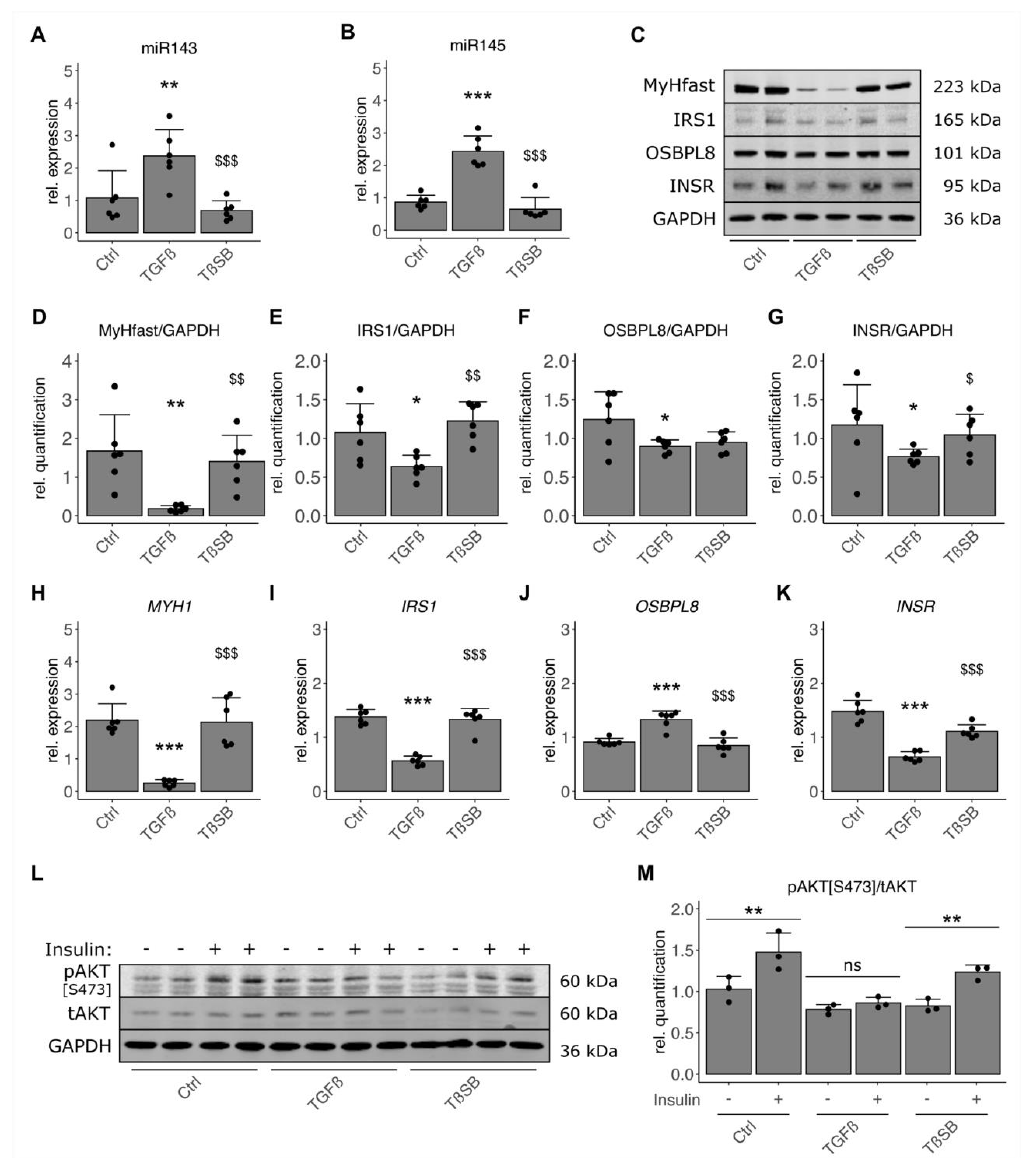
Figure 5. TGF- β 1 negatively impacts potential miR-143/145 cluster targets and insulin signaling in human skeletal muscle cells. Primary human myoblasts ( n = 6) were differentiated towards myotubes for 5 days in the absence of FBS and subsequently treated with 1 ng/mL of TGF- β 1 (TGF β ), TGF- β 1 plus inhibitor (10 µ M of SB431542) (T β SB), or vehicle control (Ctrl) for the last 48 h. Expression of mature miRNA ( A ) miR-143-3p, ( B ) miR-145-5p was detected by qPCR. ( C ) Protein levels of MYH1/2 (MyHfast), IRS1, OSBPL8, and INSR were detected by Western Blot and quantified ( D – G ) by normalizing to internal loading control GAPDH. mRNA levels of ( H ) MYH1 , ( I ) IRS1 , ( J ) OSBPL8 , and ( K ) INSR were detected by qPCR. All qPCR data were normalized to individual donors and reference RNU6 (miRNAs) or mean of RPS28 and TBP (mRNA). ( L ) Insulin-induced phosphorylation of AKT (pAKT[S473]), total AKT (tAKT), and GAPDH were detected by Western Blot after an additional 10-min stimulation with 10 nM of insulin ( n = 3). ( M ) The ratio of pAKT per tAKT was calculated after quantification. Individual datapoints are displayed, bars represent mean ± SD. All data were analyzed using one-way ANOVA with Fisher’s LSD post-hoc test. ( A – K ) * p < 0.05, ** p < 0.01, *** p < 0.001 vs. Ctrl, $ p < 0.05, $$ p < 0.01, $$$ p < 0.001 vs. TGF β , ( M ) * p < 0.05, ** p < 0.01, *** p < 0.001 vs. no insulin ( −